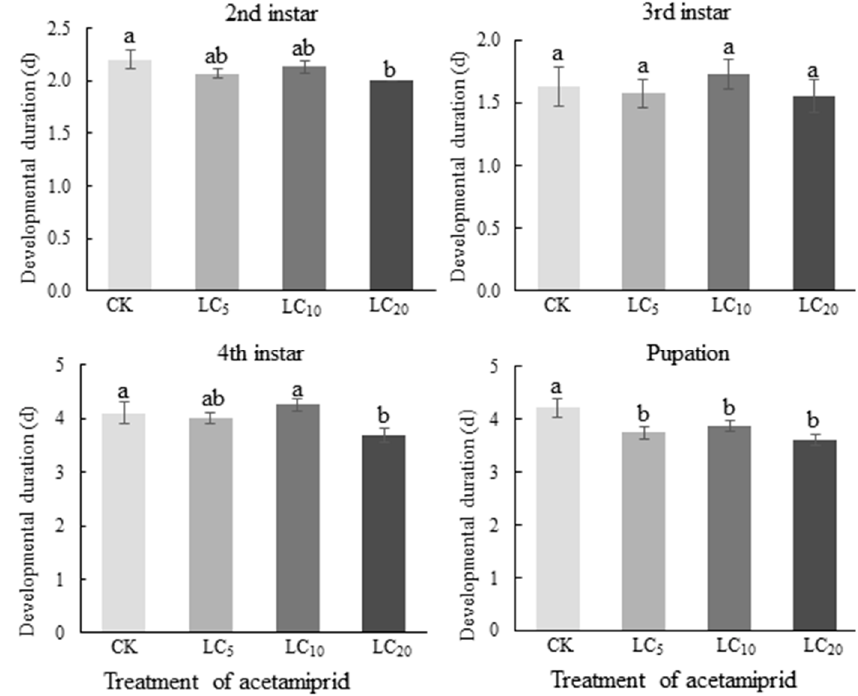
Figure 2. Effects of acetamiprid on developmental duration of C. septempunctata within 2nd instar larval stage (mean ± SE). The same column followed by different letters is significantly different based on ANOVA using Tukey’s LSD test ( p < 0.05).